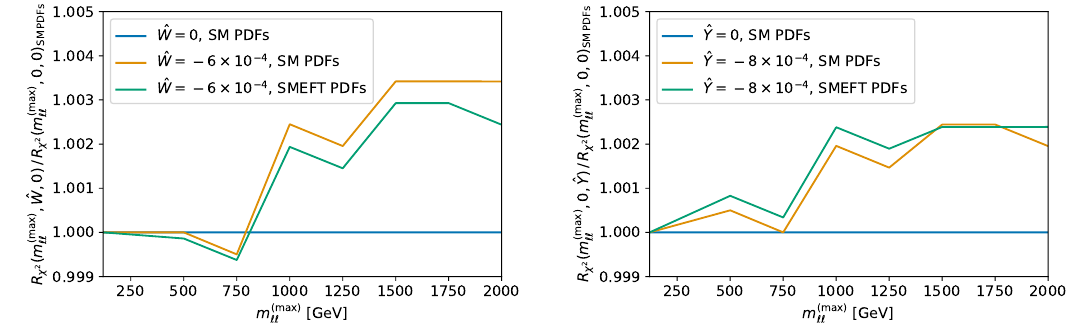
Figure 7 . The R estimator, eq. (4.5), normalised to its SM value, as a function for m (max) χ 2 representative values of ˆ W (left) and ˆ Y (right panel). We display the results obtained both with SM and SMEFT PDFs, with the horizontal line indicating the reference SM value of R